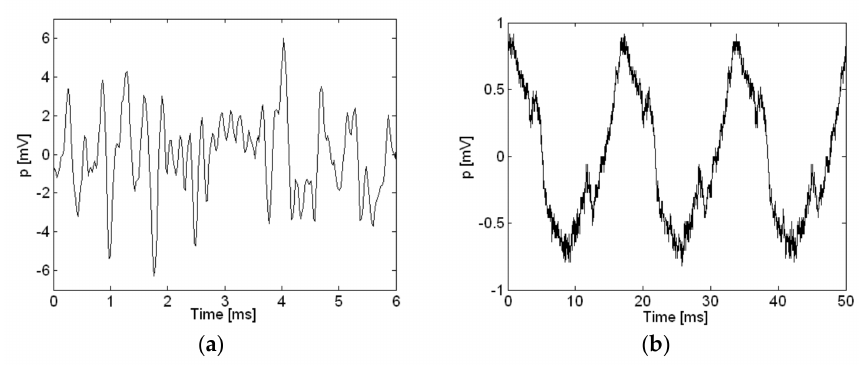
Figure 6. Reference sound pressure measurement in time domain: ( a ) Loudspeaker; ( b ) Air compressor.